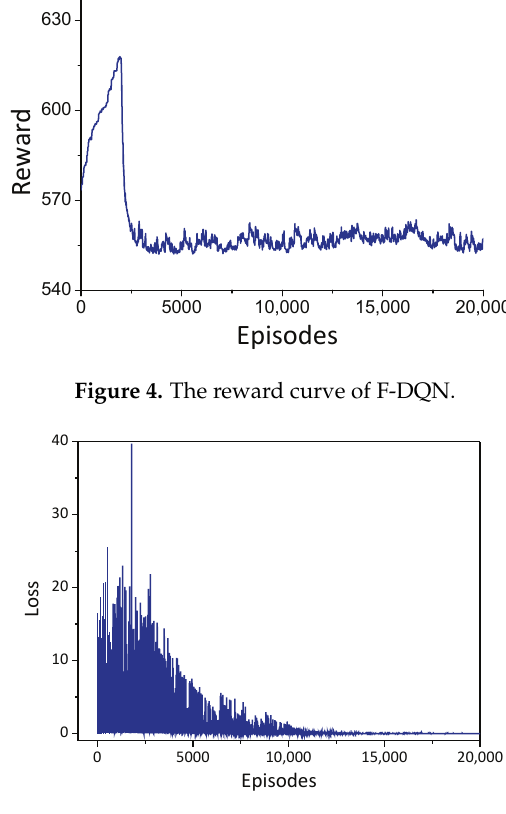
Figure 5. Training loss of